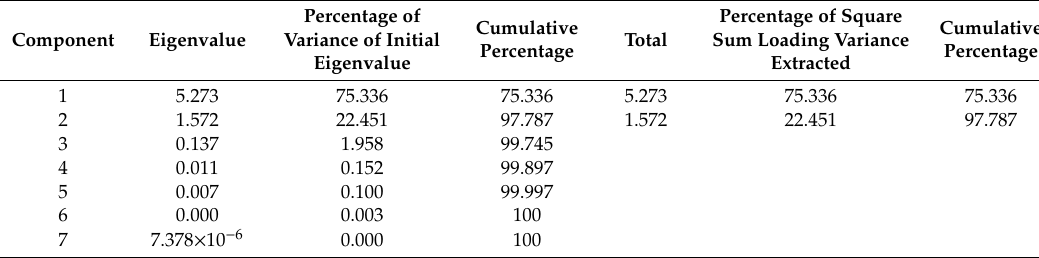
Table 6. The cumulative variance contribution rate.